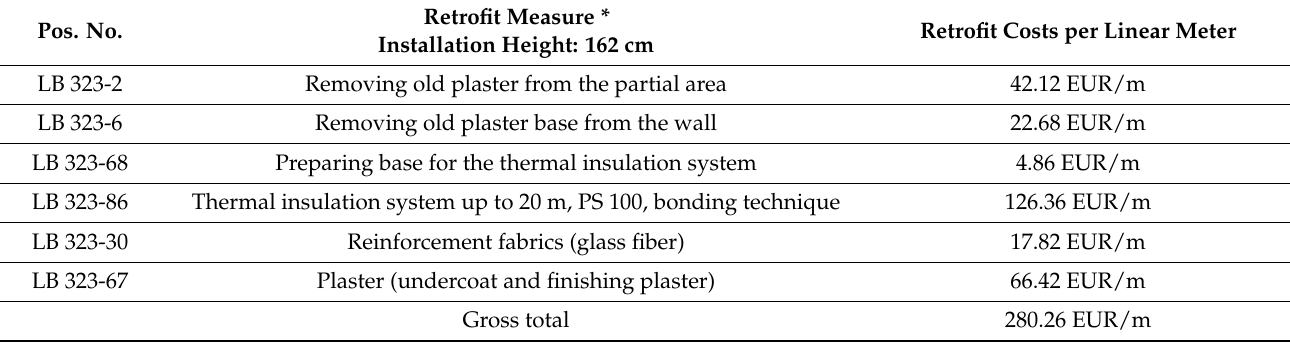
Table A22. Retrofit components and costs of the thermal bridge retrofit of an attic [38,39]. Pos. No.